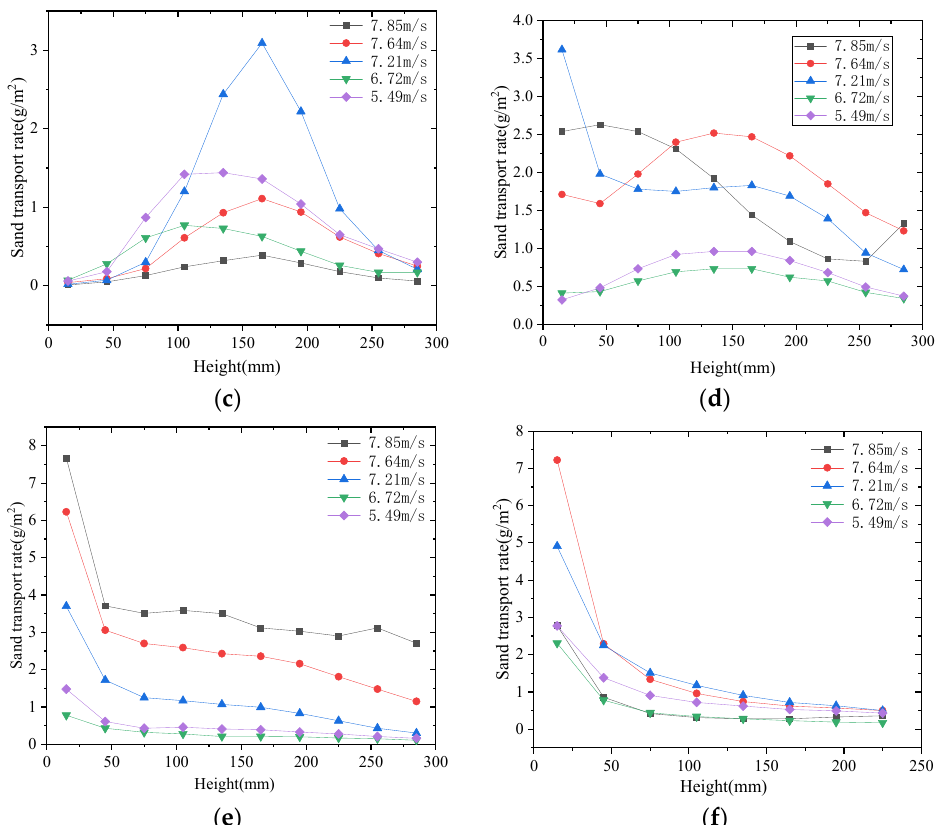
Figure 3. The sand transport rate of each sediment collecting device. ( a ) No. 1 sediment collecting device; ( b ) No. 2 sediment collecting device; ( c ) No. 3 sediment collecting device; ( d ) No. 4 sediment collecting device; ( e ) No. 5 sediment collecting device; ( f ) No. 6 sediment collecting device.